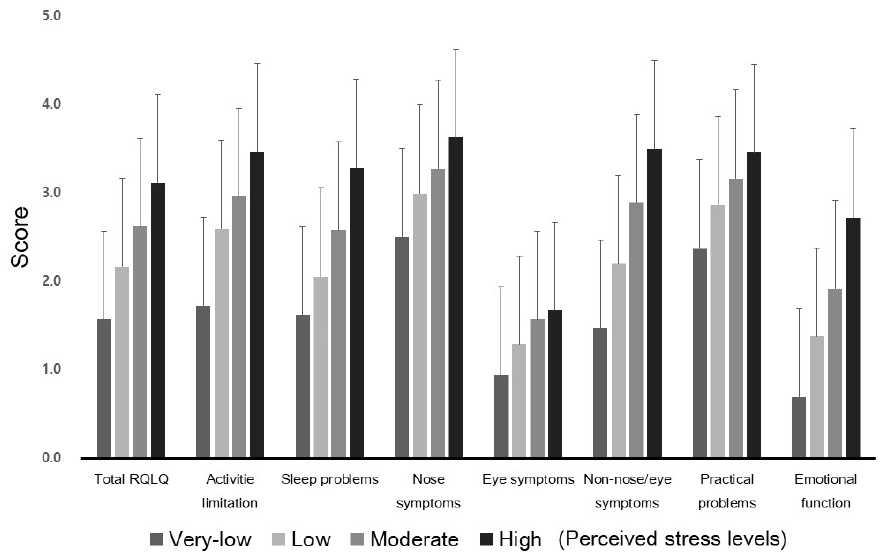
Figure 1. Total RQLQ score and domain scores according to perceived stress levels. The scores are shown as means with standard deviation. RQLQ: rhinoconjunctivitis quality of life questionnaire.